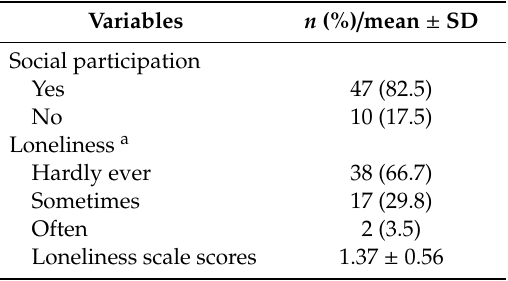
Table 3. Social isolation in Japanese older